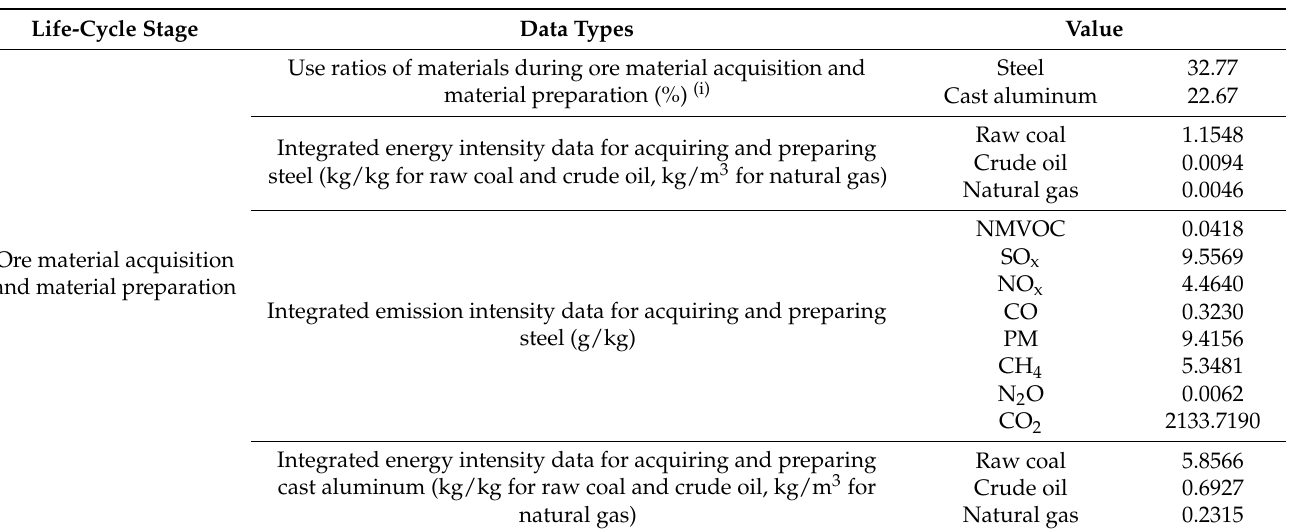
Table A2. Specific inventory data for different life-cycle